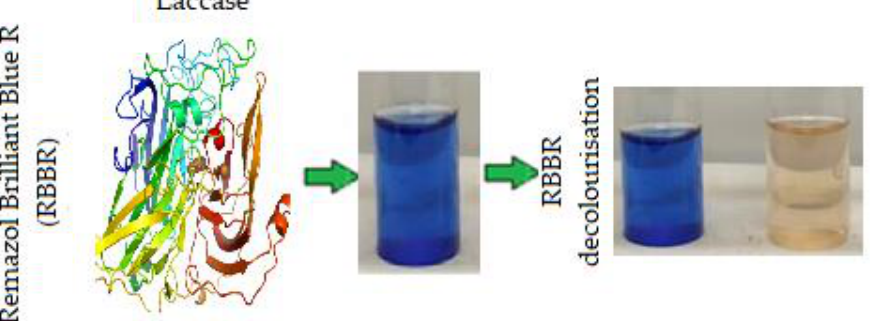
Figure 9. Biodegradation of RBBR (modified from [80]).